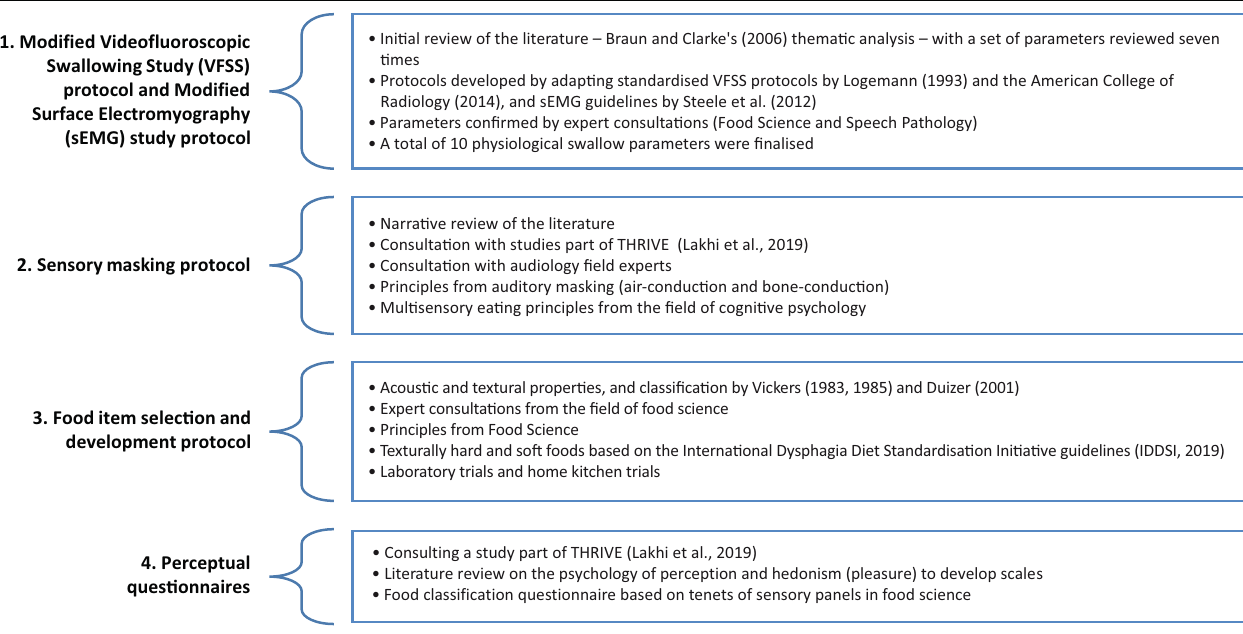
FIGURE 2-A2: Self-developed protocols and tools associated with phase